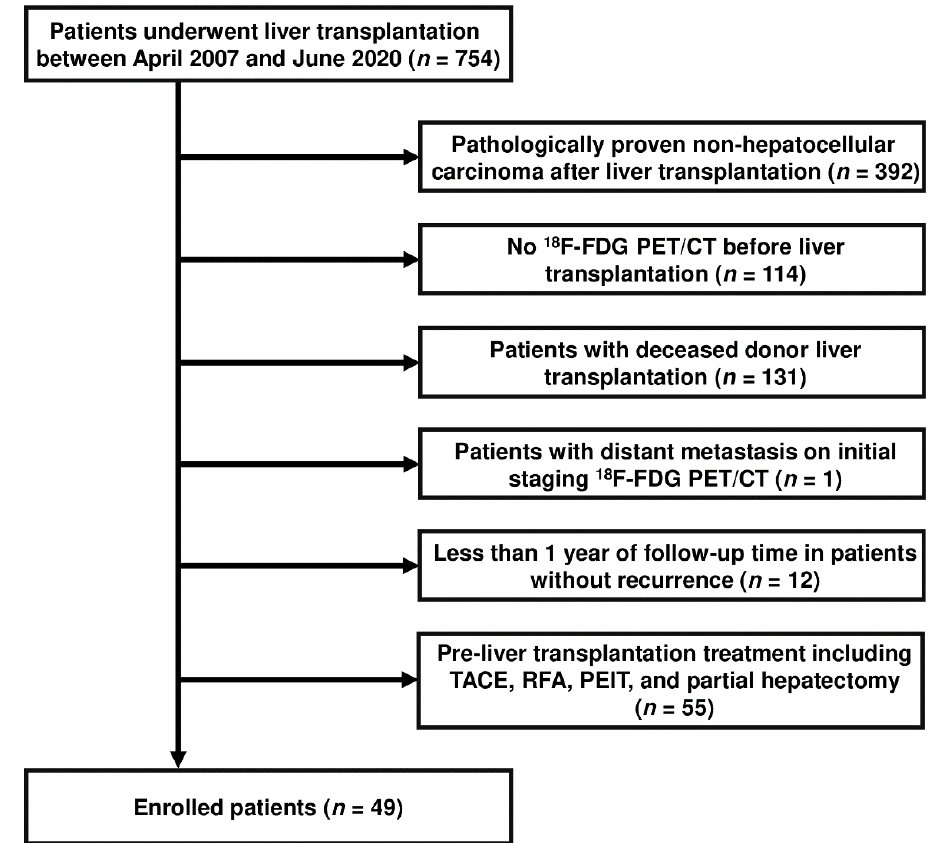
Figure 1. Flow chart for inclusion and exclusion of patients in this retrospective study.